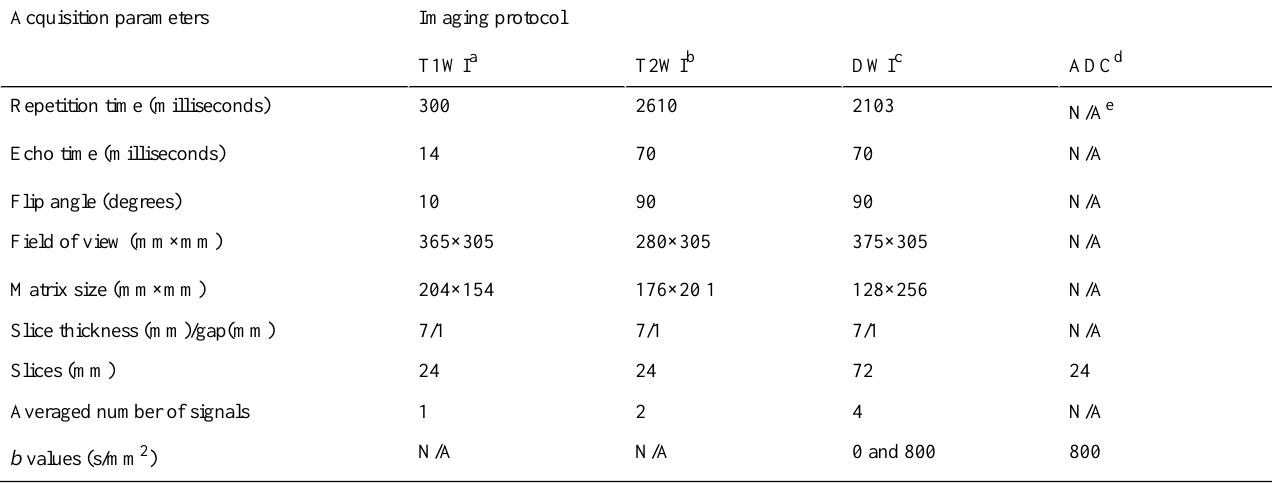
Table 1. The acquisition parameters of the abdominal magnetic resonance imaging (MRI) protocol.